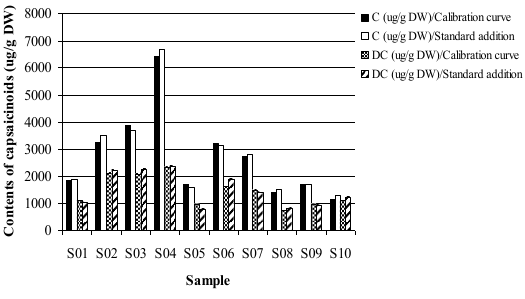
Figure 5. Each of the optimum conditions for ASE of capsaicin and dihydrocapsaicin, where M1: 5 min static time & 3 extraction cycles; M2: 3 min static time & 5 extraction cycles.